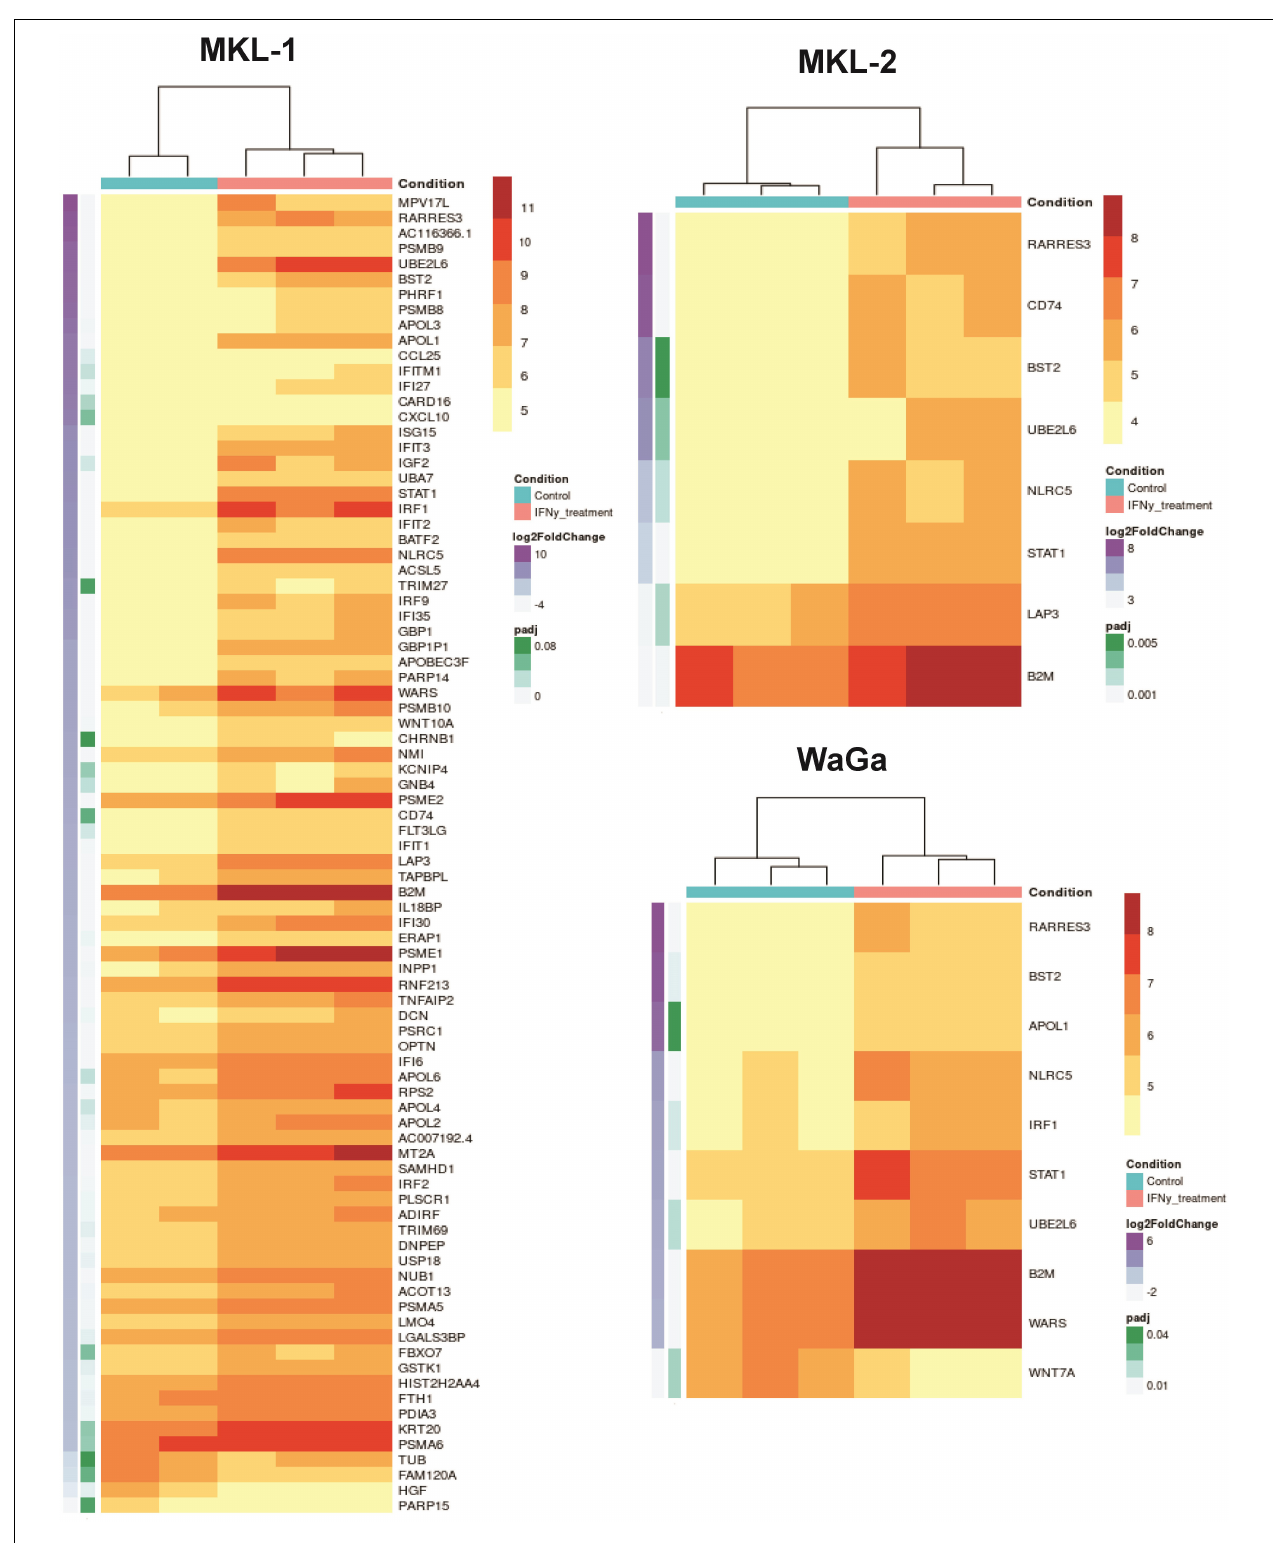
FIGURE 4 | Differentially expressed genes of the cell lines MKL-1, MKL-2, and WaGa illustrated in heatmaps. Cell lines were incubated with IFN γ (blue top labels) or without IFN γ (pink top labels). Adjusted p -values are indicated in green and log 2 fold change in purple on the left side. Listed genes were differentially expressed with a false discovery rate-adjusted p -value < 0.1 and an absolute fold change > 2. A total of 86 genes was detected in MKL-1, eight genes in MKL-2, and 10 genes in WaGa cells. Heat scale represents vst-normalized counts using DESeq2.